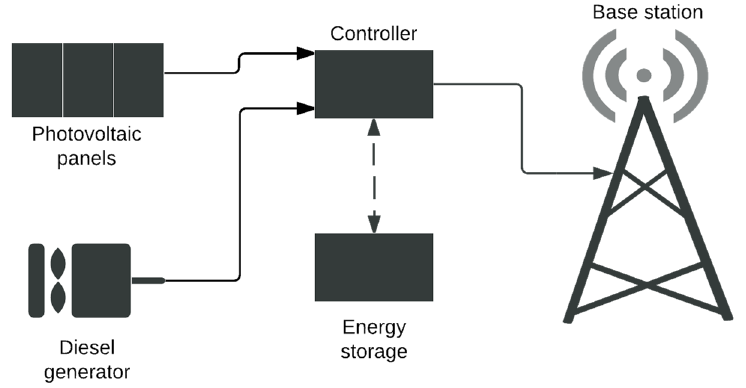
Figure 3. Typical configuration of a hybrid PV-diesel system in a base station